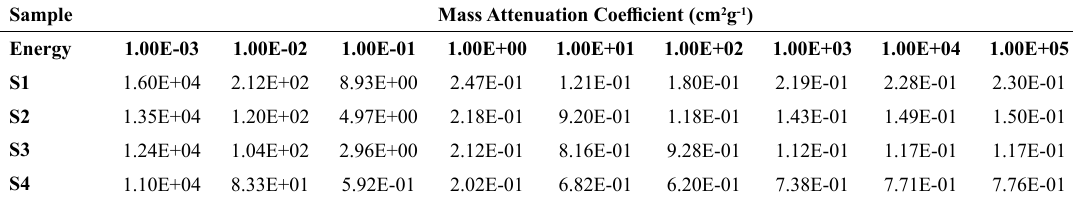
Table 3. Mass Attenuation Coefficients (µm) of Glass Sample Sample